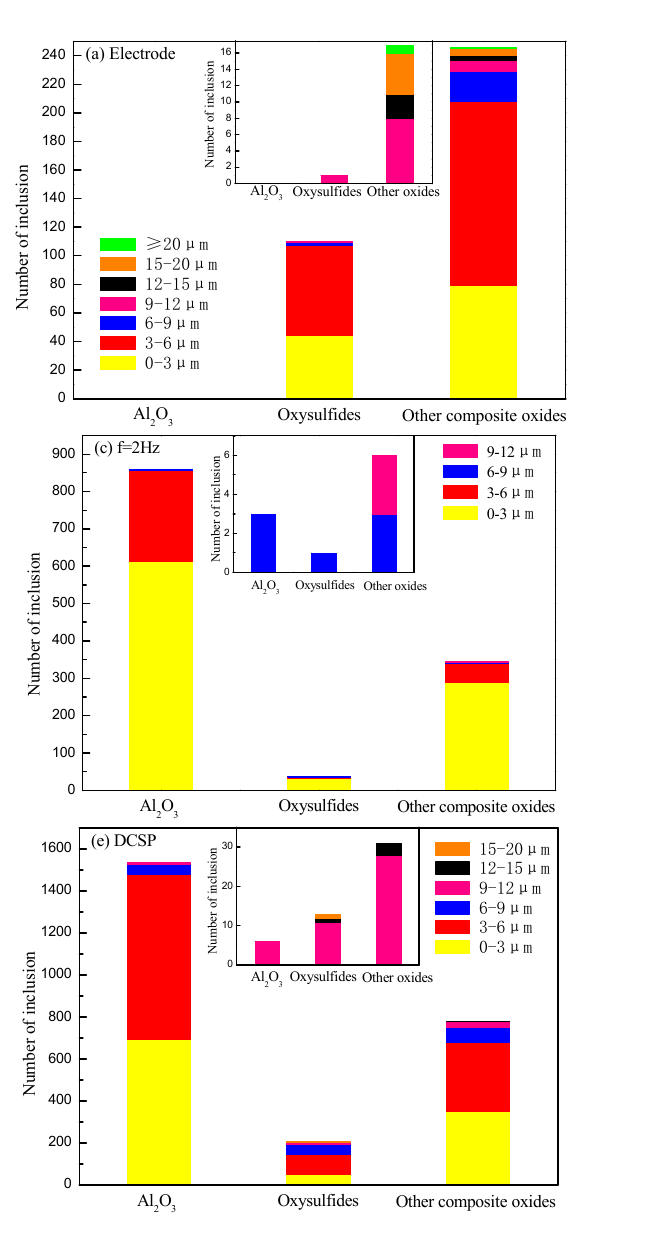
Figure 8. Variation of number and size of different types of inclusions with different power supply modes.